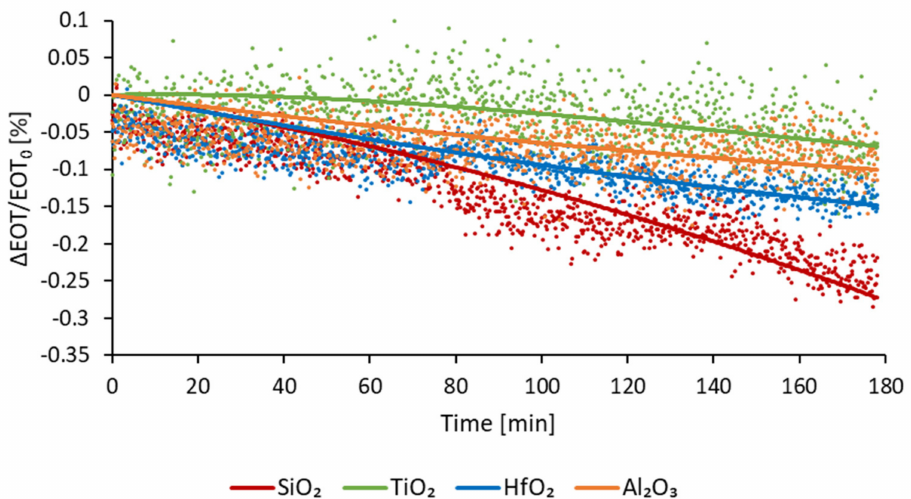
Figure 8. Relative EOT optical response of passivated membranes as a function of time while exposed to a continuous PBS flow.